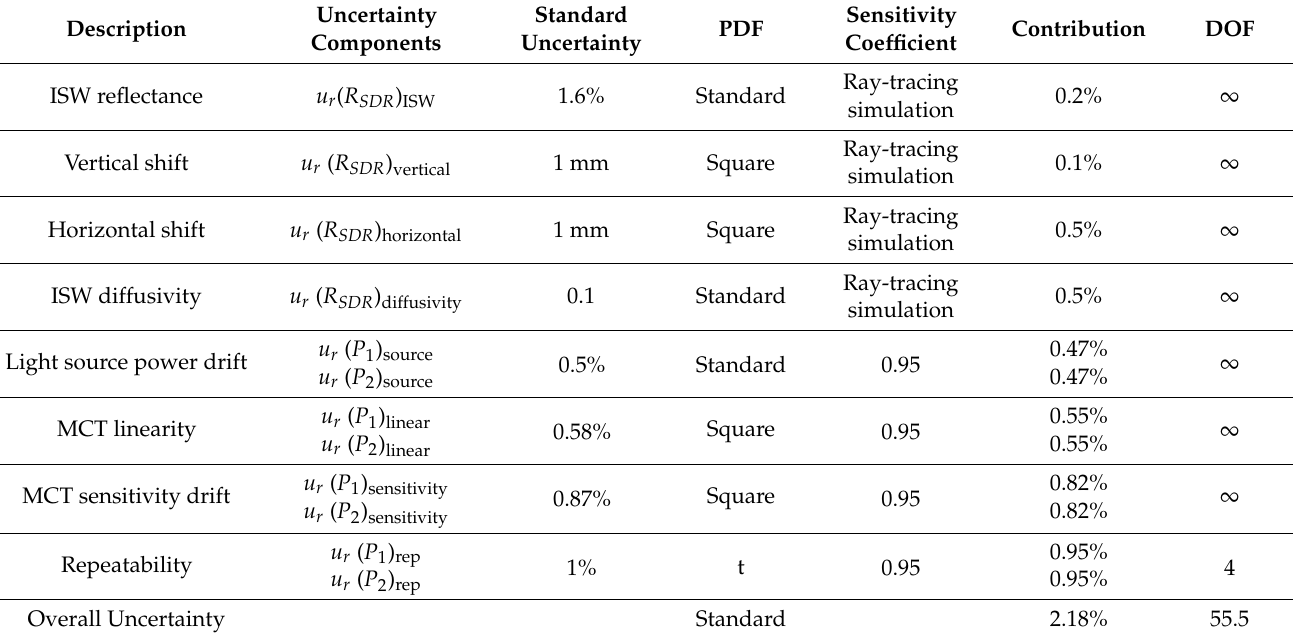
Figure 9. Spectral diffuse reflectance of the homemade SDR (Korea Research Institute of Standards and Science (KRISS)) compared to that by National Institute of Standards and Technology (NIST). Table 1. Uncertainty factors and evaluated overall uncertainty for absolute reflectance measurement (ISW diffusivity is valid at 2 µ m; PDF: probability distribution function; DOF: degree of